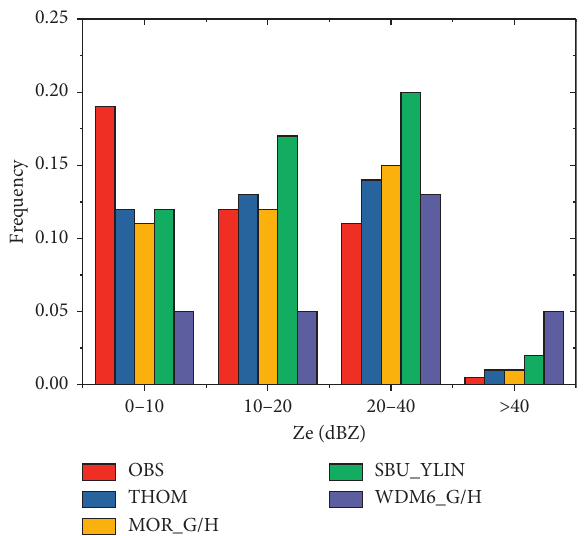
Figure 8: Comparisons of radar reflectivity (Ze, dBZ) frequency at 3km altitudes from observations and simulations. The analysis domain is shown in Figure 1(a). The occurrence frequency is calculated by the number of grid points falling in each Ze range divided by the total number of the grid points of the analysis domain using output from 0000 UTC to 1200 UTC on 30 June